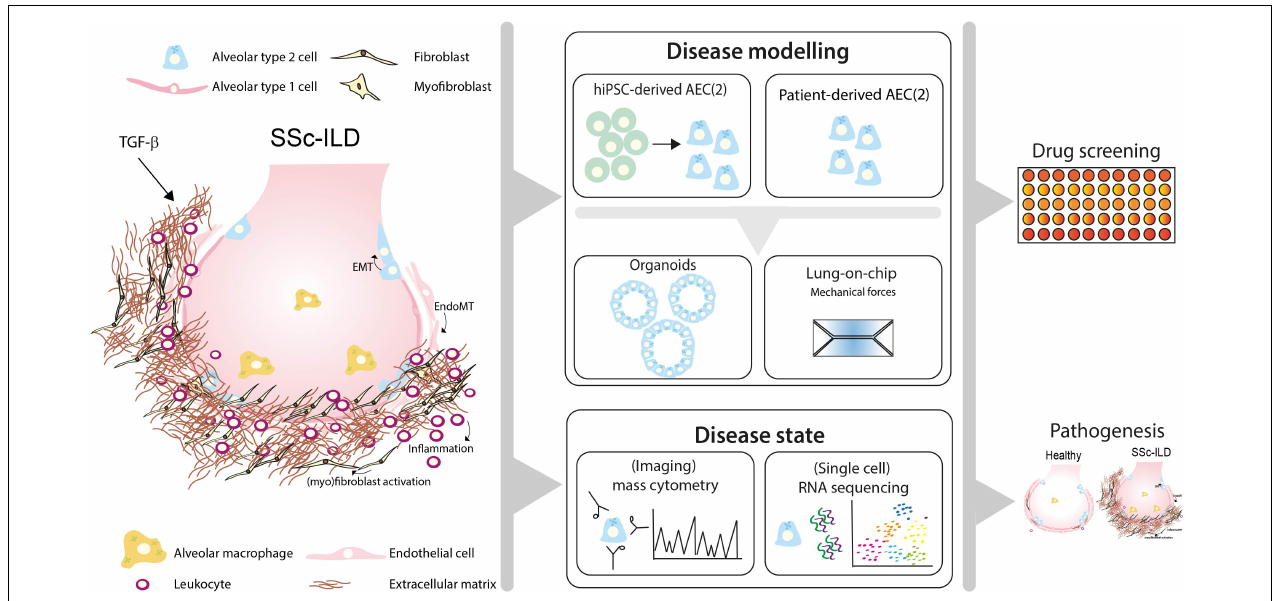
FIGURE 1 | Toward personalized-medicine-based prediction, target identification and drug screening models of SSc-ILD. In SSc-ILD, the interactions and cross-talk between various cell types, including in type 2 alveolar cells (AEC2), AEC1, endothelial cells, fibroblasts and immune cells is disturbed. This may be partly explained by excessive TGF- β signaling activation, leading to AEC1/2 and endothelial cell (EC) transition into a mesenchymal phenotype, (myo)fibroblast activation and proliferation and excessive interstitial extracellular matrix (ECM) deposition. Recruited leukocytes further contribute to the profibrotic environment, leading to lung tissue remodeling and fibrosis. Patient-derived pulmonary cells, either isolated from lung tissue or derived from human induced pluripotent stem cells (hiPSC), can be used to study patient-specific responses in vitro using organoid SSc-ILD disease models. Lung-chip models may add another layer of complexity containing physiological ques, including breathing motions, air-blood flow and stretch, which are often lacking in current available in vitro lung models. Disease-specific features can be measured using cutting-edge techniques such as single-cell-RNA-sequencing and (imaging) mass cytometry. Integrating information derived from SSc-ILD disease models using cells derived from SSc-ILD patients and triggers implicated in disease pathogenesis may lead to novel mechanistic insight and offer a platform for identification of pathogenic processes and drug screening for